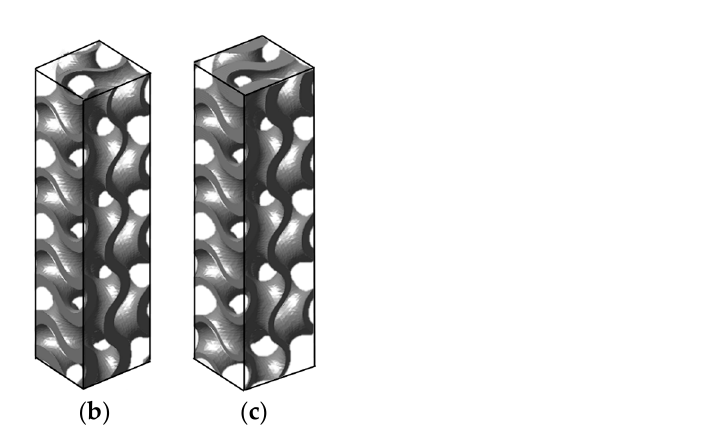
Figure 10. Sheet-Gyroid structure with the same porosity of 70% (The TPMS structures are generated using MSLattice software [22]); ( a ) Uniform porosity; ( b ) Positive porosity; ( c ) Negative porosity.